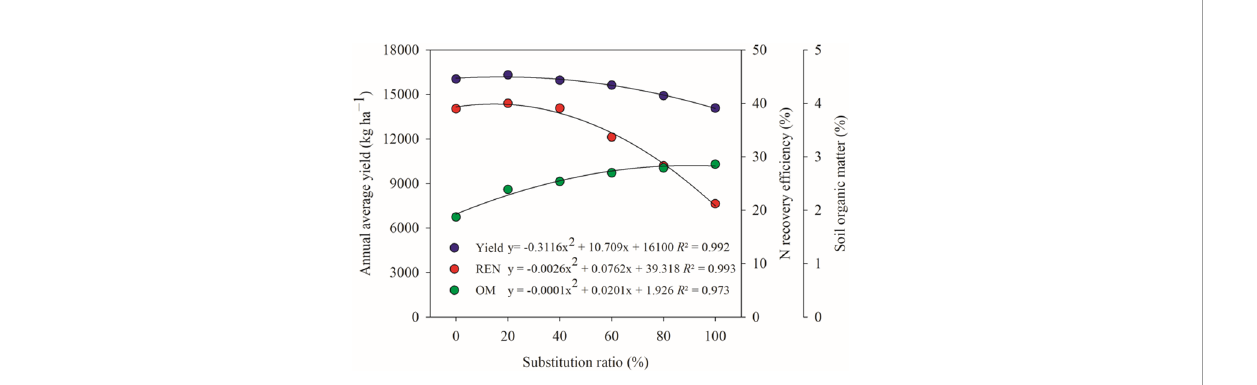
FIGURE 4 Relationship between different N fertilizer substitution ratios and average annual yield, N recovery ef fi ciency (REN) and soil organic matter (OM) content in the wheat-maize rotation